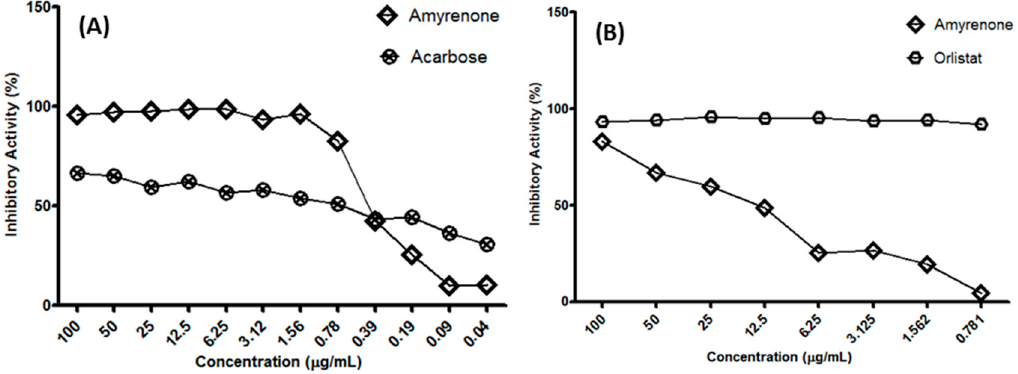
Figure 5. ( A ) Inhibitory Activity (%) of isomers of α , β -amyrenone on α -glucosidase enzyme. The data analyzed in t test demonstrated value of 0.0002; ( B ) Inhibitory Activity (%) of α , β -amyrenone on pancreatic lipase enzyme and comparison with the standard orlistat.